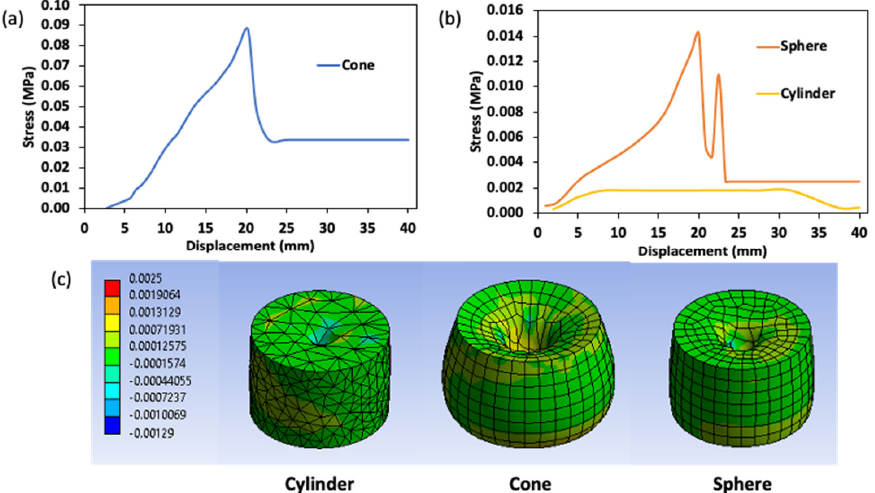
Figure 7. Stress curve of various penetration probes during puncture analysis for surimi gel; ( a , b ) quantitative stress value and ( c ) contour description of the stress distribution in a puncture gel at a depth of 20 mm.